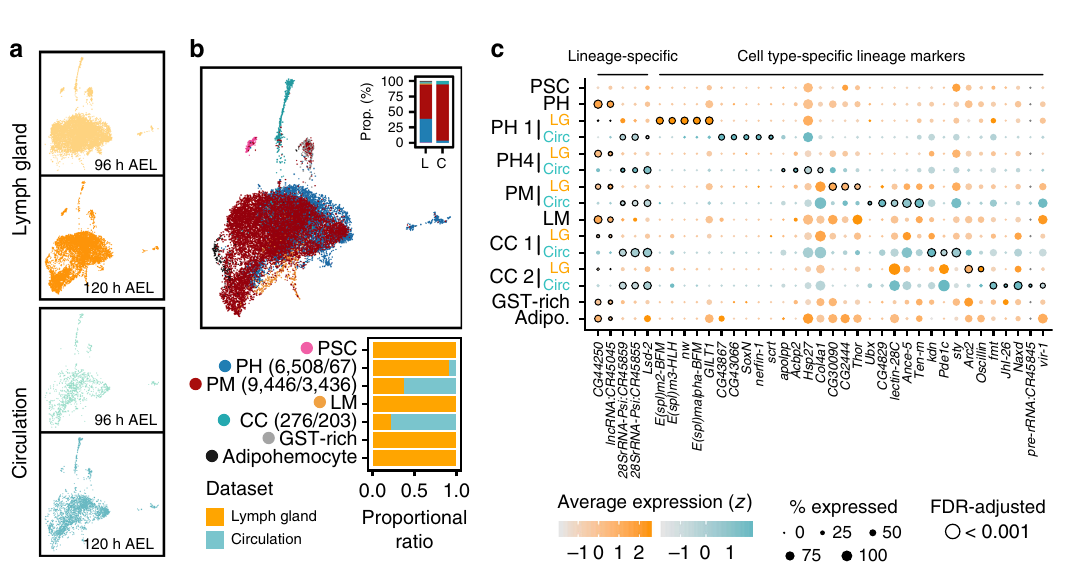
Fig. 7 Lymph gland hematopoiesis following wasp infestation. a Three-dimensional pseudotime trajectory of subclustered cells from the normal lymph gland dataset. Colors indicate cell types. b Expression patterns of 14 marker genes – kn ( col ), IM18 , Ance , Tep4 , Hml , Pxn , eater , vkg , NimC1 , Pvr , atilla , Dbi , ItgalphaPS4 , and CG1208 – in two-dimensional (UMAP 1 and 3) pseudotime trajectory. Color bar denotes the log 10 -scaled level of gene expression. Gray color indicates no expression. c A three-dimensional trajectory landscape of major cell types under wasp infestation (left), and additional representation of trajectory over calculated pseudotime using Monocle3 (right). Box indicates the cells used for subtrajectory analysis in d . Colors in legends show pseudotime (right). d Subtrajectory analysis of four subclusters — iPH4, iPM1, iLM1, and iLM2 — detected in the trajectory to iLM (left). Two different waves, arrow 1/2 (iPH4/NimC1 − iPM1, thus, intermediate cells) and arrow 3 ( NimC1 + iPM1), advance towards iLM with distinct gene modules (right). Shared gene modules between iPH or iPM with iLM are indicated in boxes. Colored scale represents the z -transformed mean expression level of gene modules. e Lamellocytes differentiate from intermediate iPHs ( Nplp2-gal4 UAS-GTRACE ) or iPMs ( Hml-gal4 UAS-GTRACE ) upon wasp infestation. Nplp2 + iPHs (green, traced; blue, DAPI; top) or Hml + iPMs (green, traced; blue, DAPI; bottom) express atilla (magenta) upon wasp infestation. Insets indicate magni fi ed views of atilla + cells. Cyan dotted lines within insets demarcate traced iLMs. f iLM and iCC lineages are separable. iLMs emerge independently of iCCs ( lz- gal4 DBD , Pxn-gal4 AD UAS-GTRACE ). lz-gal4 DBD , Pxn-gal4 AD UAS-GTRACE trace the majority of lz -expressing crystal cells (lz, magenta; traced, white). However, atilla + iLMs are lz DBD /Pxn AD -negative (atilla, cyan; traced, white). White scale bar, 30 μ m; yellow scale bar, 3 μ m. Lymph glands are demarcated by white dotted lines. Magni fi ed images are shown on the right of each panel.